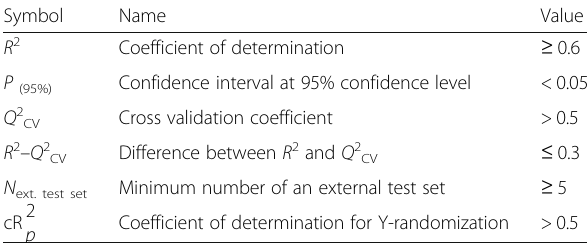
Table 5 Minimum suggested value of authentication parameters for a generally satisfactory QSAR